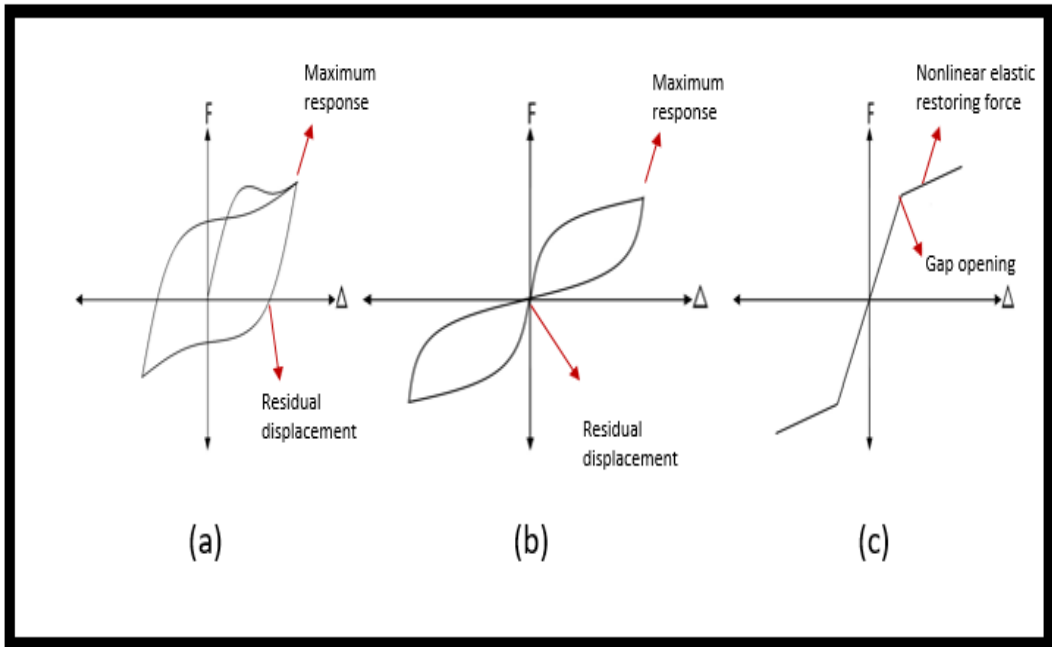
Figure 6. ( a ) Hysteretic behavior of conventional shear walls, ( b ) typical hysteretic behavior of ideal self-centering systems, and ( c ) restoring force in rocking systems and gap opening using PT tendons.